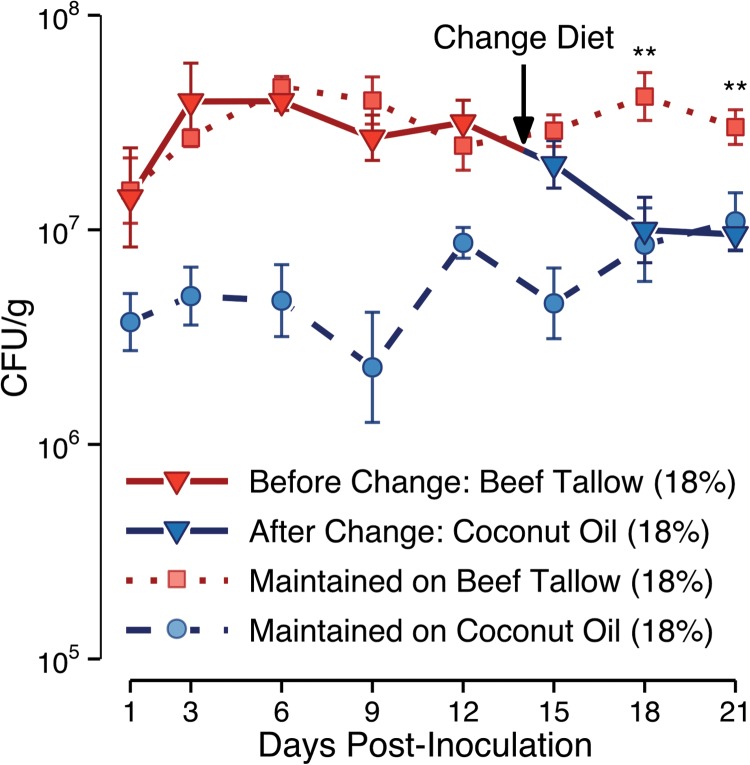
Changing to a coconut oil-containing diet reduces preexisting GI colonization by C. albicans. Mice on a beef tallow-containing diet (18% by weight) were inoculated with C. albicans, and colonization was measured using fecal pellets collected on the days indicated. Fourteen days postinoculation, mice were switched to a coconut oil-containing diet (18% by weight); data from mice maintained on the beef tallow- or coconut oil-containing diet throughout the experiment are shown for comparison. Eighteen days postinoculation (4 days after the change in diet), colonization in mice switched from the beef tallow to the coconut oil diet was lower than that in mice maintained on the beef tallow diet and was not significantly different from that in mice fed the coconut oil-containing diet throughout the experiment. Data shown as geometric means ± standard errors; n = 8 to 12 mice per diet. **, P ≤ 0.01, Tukey’s HSD test.